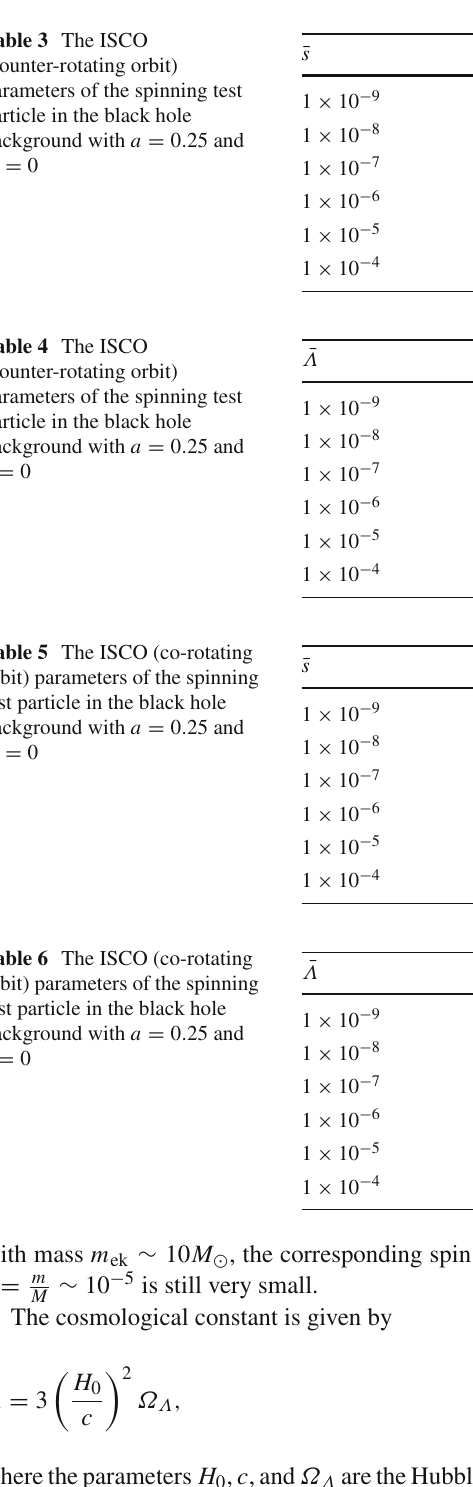
(counter-rotating orbit) parameters of the spinning test particle in the black hole background with a = 0 . 25 and